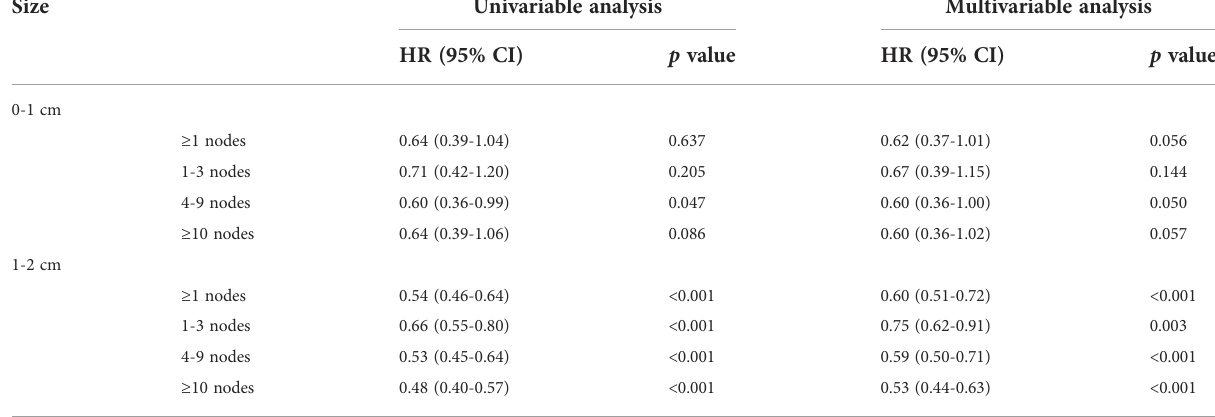
TABLE 2 Univariable and multivariable analysis of overall survival among patients undergoing lobectomy with different number of lymph nodes resected (0 as reference). Size Univariable analysis Multivariable analysis HR (95% CI) p value HR (95% CI) p